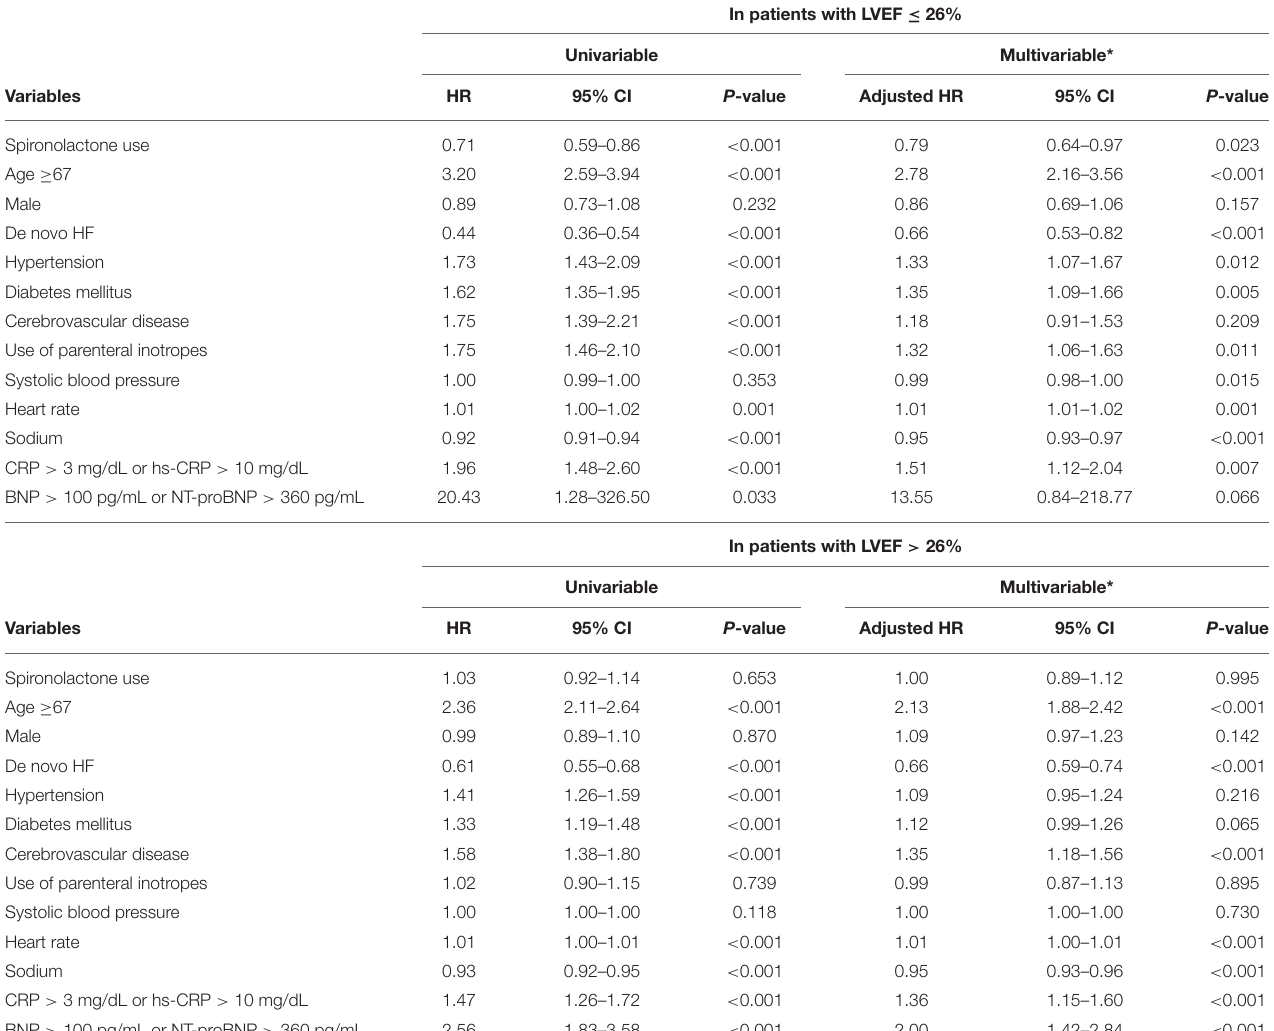
TABLE 2 | Predictors for 3-year all-cause mortality in patients according to LVEF.